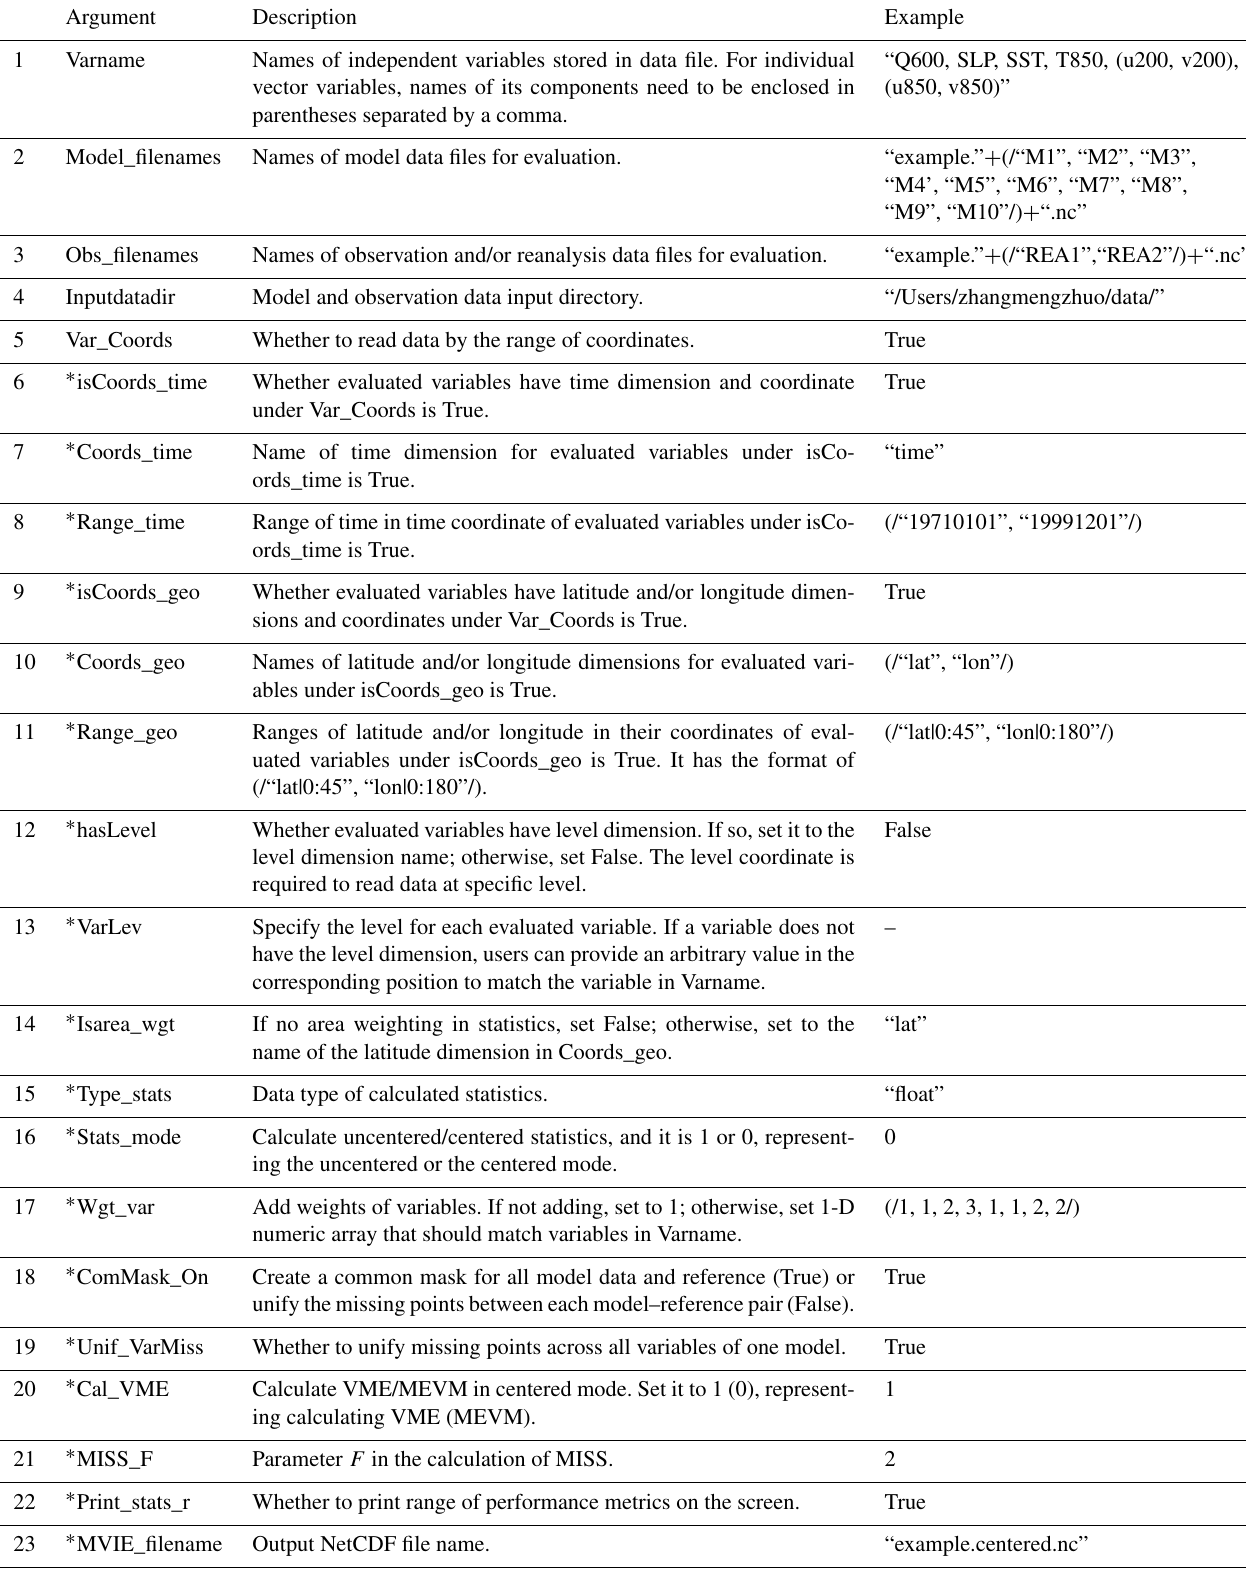
Table 1. Input arguments to Calculate_MVIE.ncl in the MVIETool. An argument with ∗ is optional. The rightmost column provides examples of these